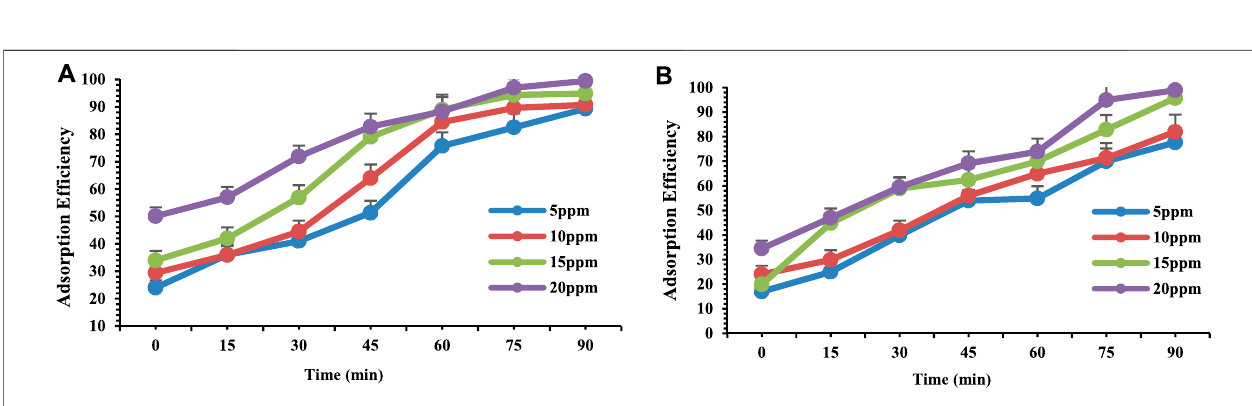
FIGURE 6 | Adsorption ef fi ciency of 10 ppm (A) Chromium and (B) Lead at PH4 on orange peel/selenium nanocomposite as a function of temperature.